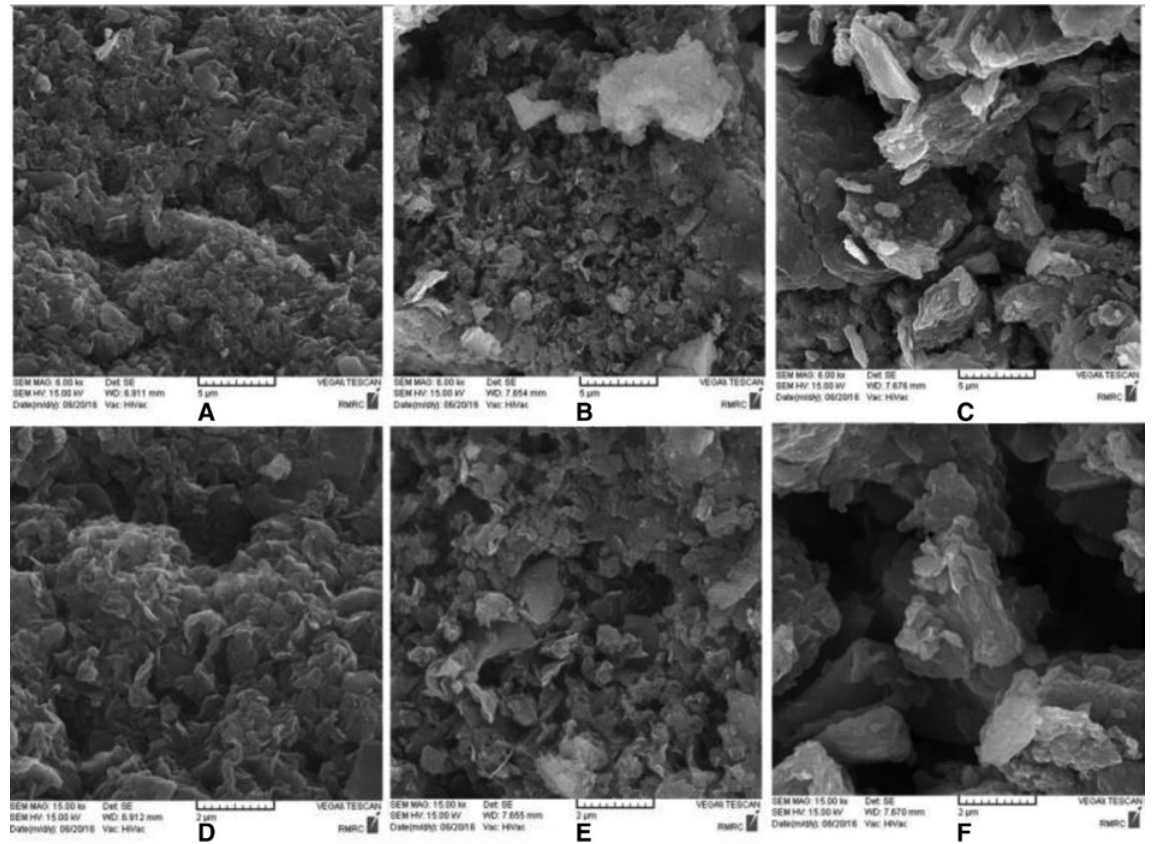
Figure 5: SEM images: MgO-GO1, MgO-GO2, and MgO-GO3 samples at (A–C) 6000 × magnification and (D–F) at 15,000 ×